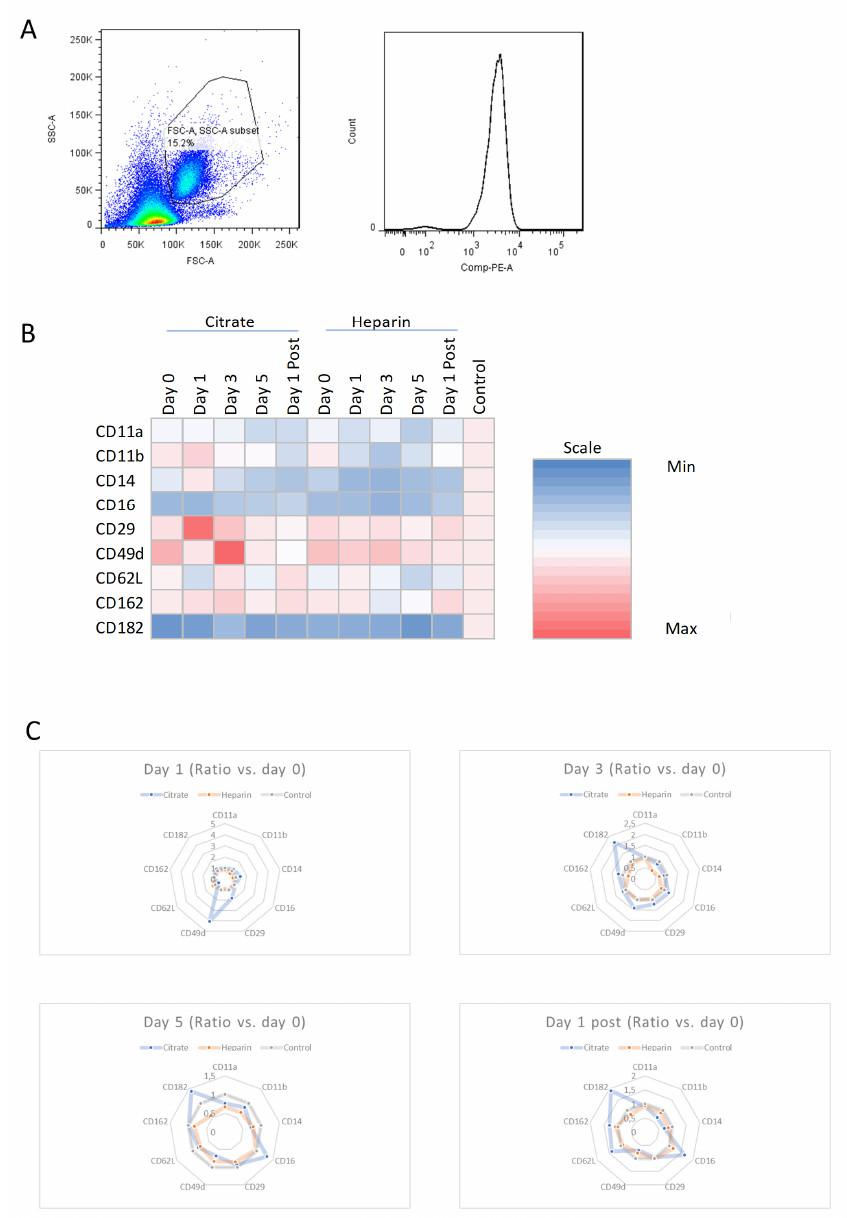
Figure 2. Leukocyte phenotype profiles. ( A ) Representative gating strategy of flow cytometry data is shown for determination of neutrophils. ( B ) Heat-map representation of expression levels indicative of leukocyte phenotype profiles relative to healthy control expression levels. ( C ) Spider-graph representation of expression levels relative to group-expression levels before CVVH initiation (d0).